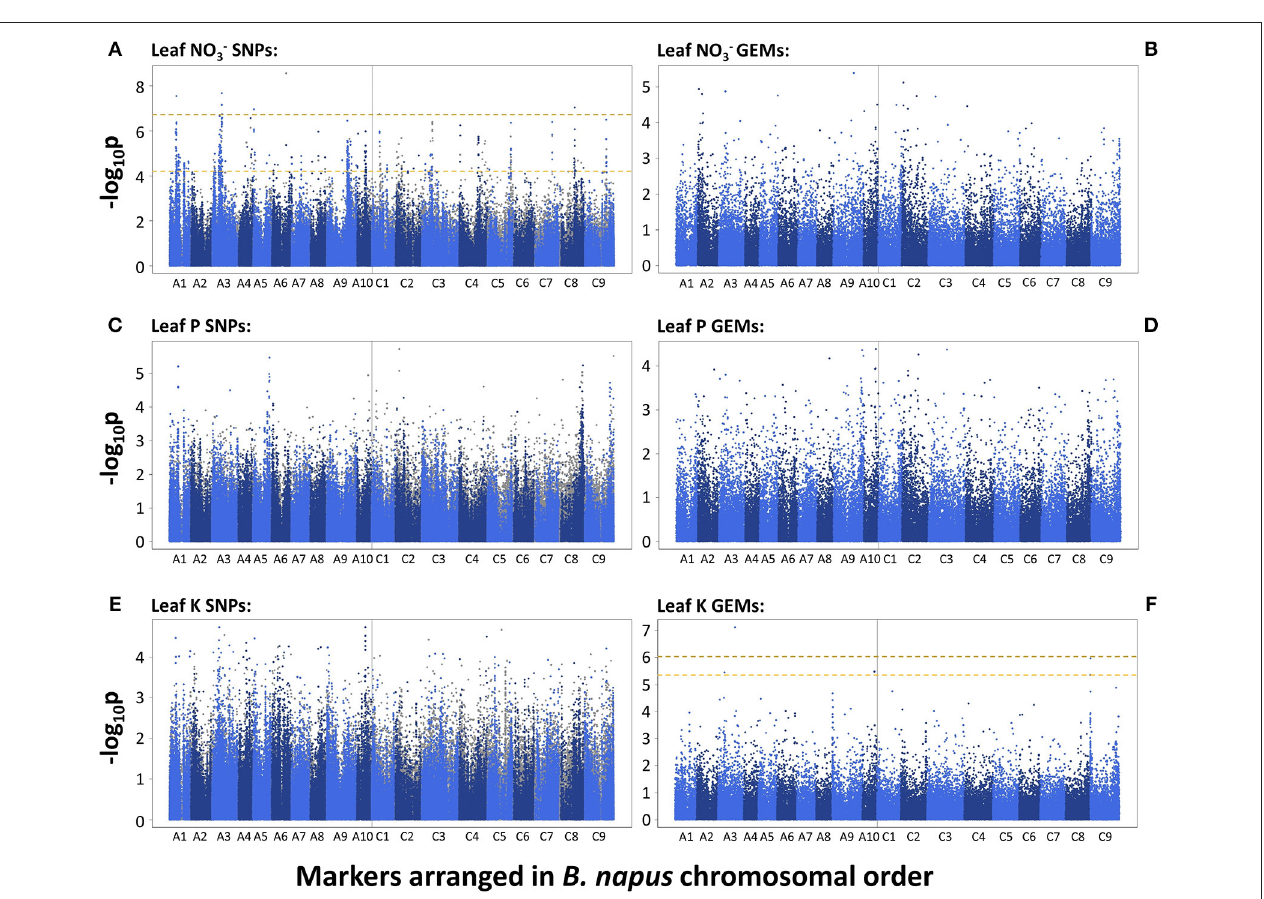
FIGURE 2 | –log 10 p -values of SNPs and GEMs associated with leaf nitrate concentration ( A , B , respectively), leaf phosphorus concentration ( C , D , respectively) and leaf potassium concentration ( E , F , respectively) in order of markers within the Brassica napus pan-transcriptome. Upper, gold, dashed line represents Bonferroni corrected significance threshold; lower, yellow, dashed line represents FDR corrected significance threshold ( p =